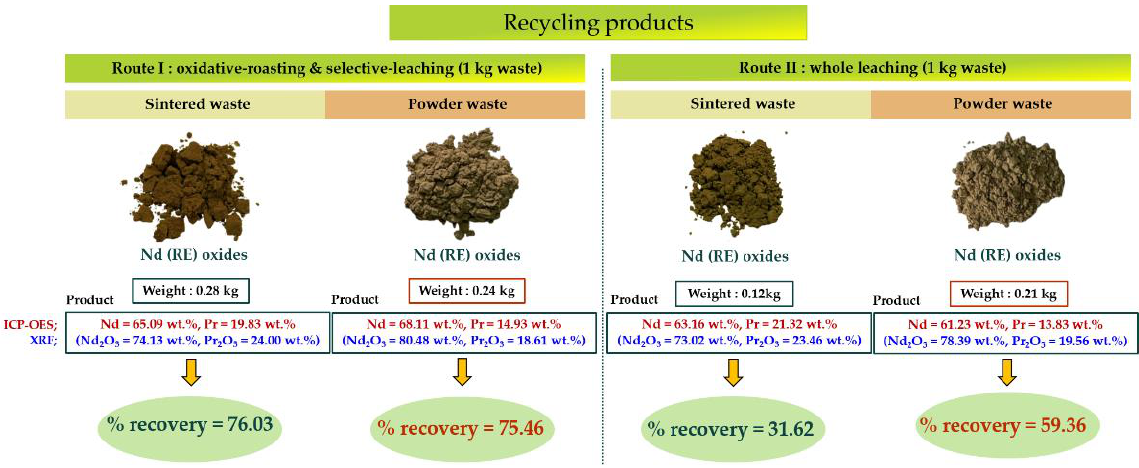
Figure 16. Recycling products, composition, phases and recovery for sintered and powder NdFeB